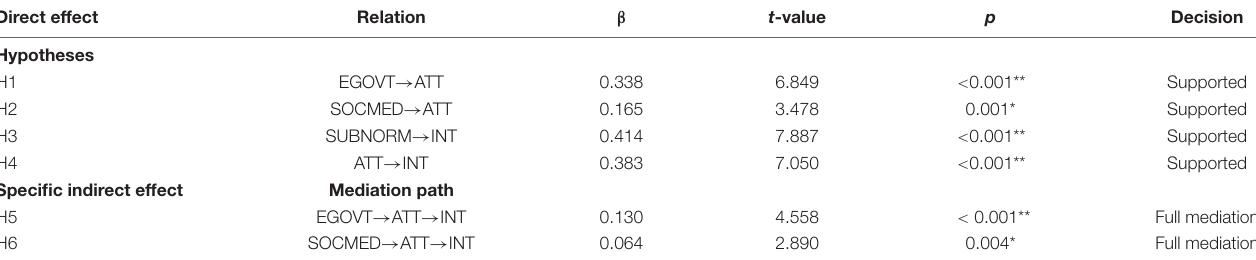
TABLE 4 | Structured model.